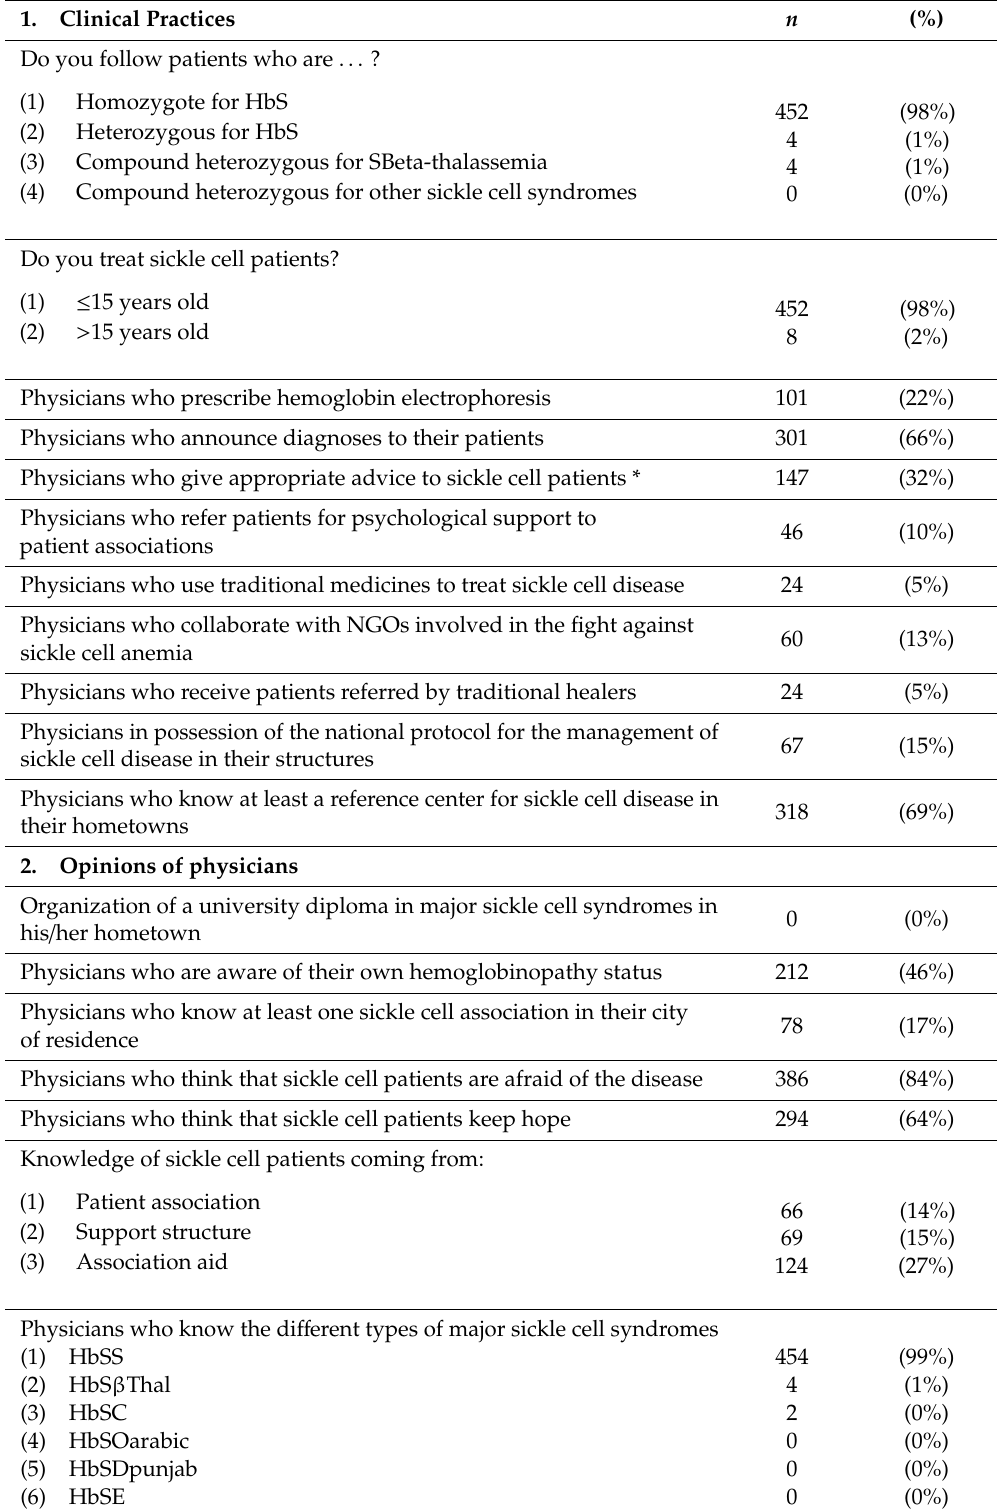
Table 1. Clinical practices and opinions of Congolese physicians about sickle cell disease ( n =